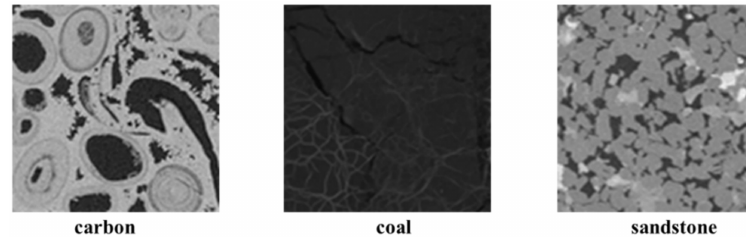
Figure 8. Training set.